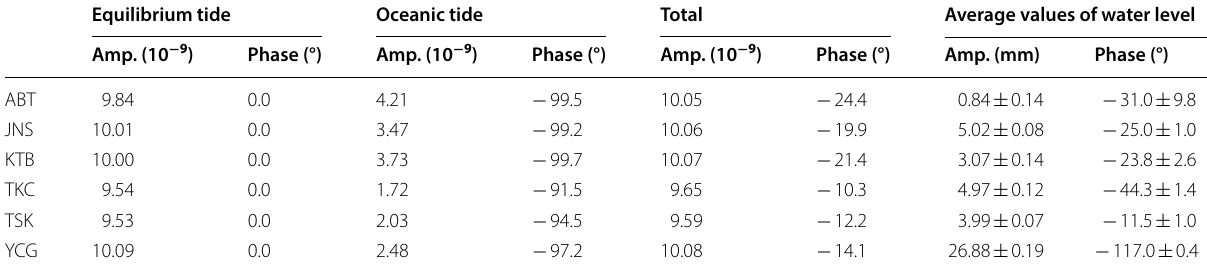
Negative phase shifts correspond to lags behind the equilibrium tide